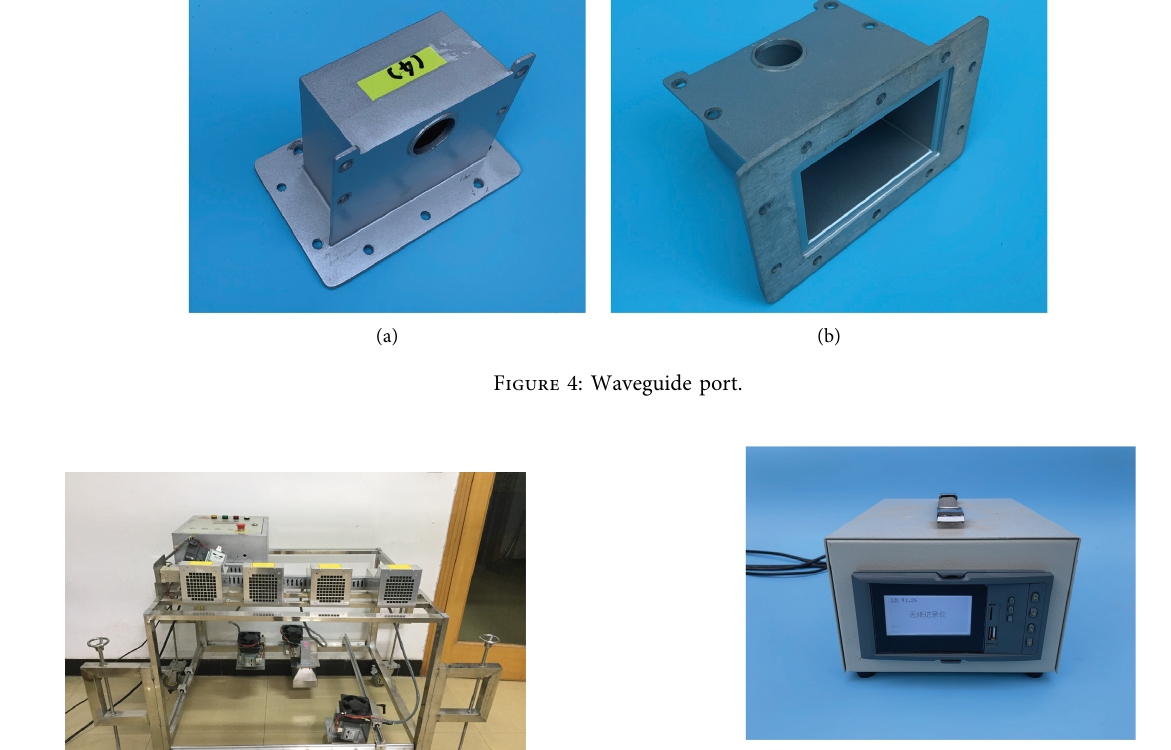
Figure 7: Paperless recorder. Table 3: Grouping table of carbon fiber concrete